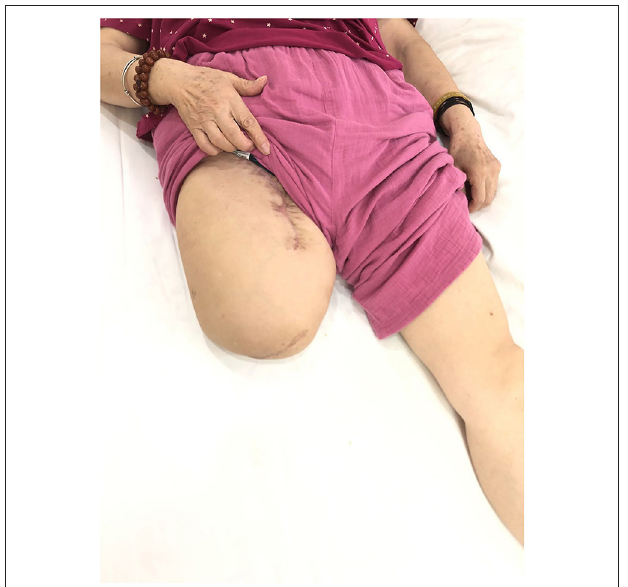
FIGURE 1 | The patient’s condition after right thigh amputation and inguinal lymph node dissection.